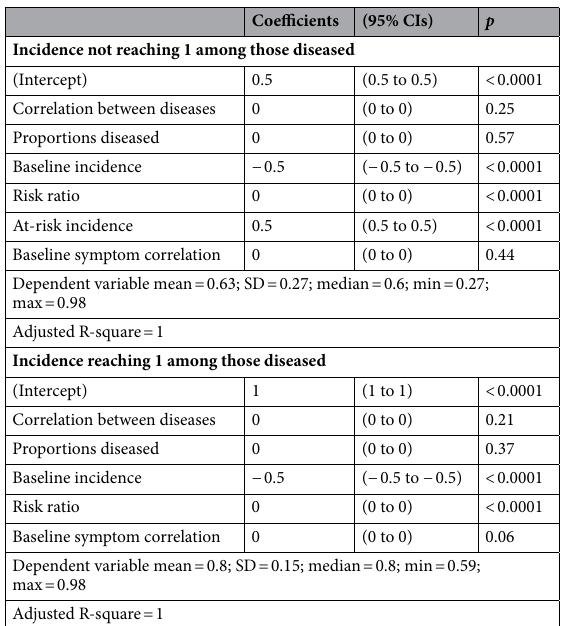
Table 7. Effects of baseline incidence, proportions diseased, risk ratios, and baseline symptom correlations on the area under the receiver operating characteristic curve of individual symptoms for disease diagnosis. CI confidence interval, SD standard deviation.